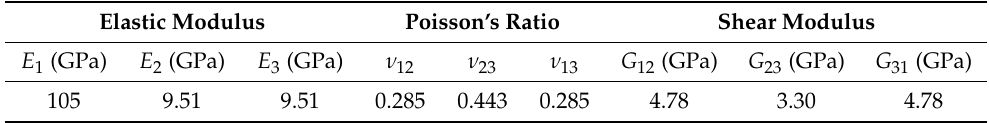
Table 1. Elastic properties of ply AS4/3501 [20].